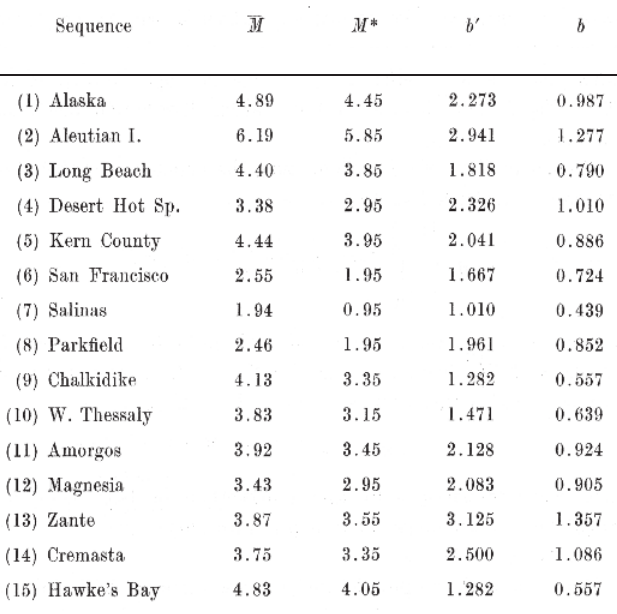
Table 9. Estimation of the parameter b in the magnitude-frequency law. Table 10. Validity of the magnitude-frequency